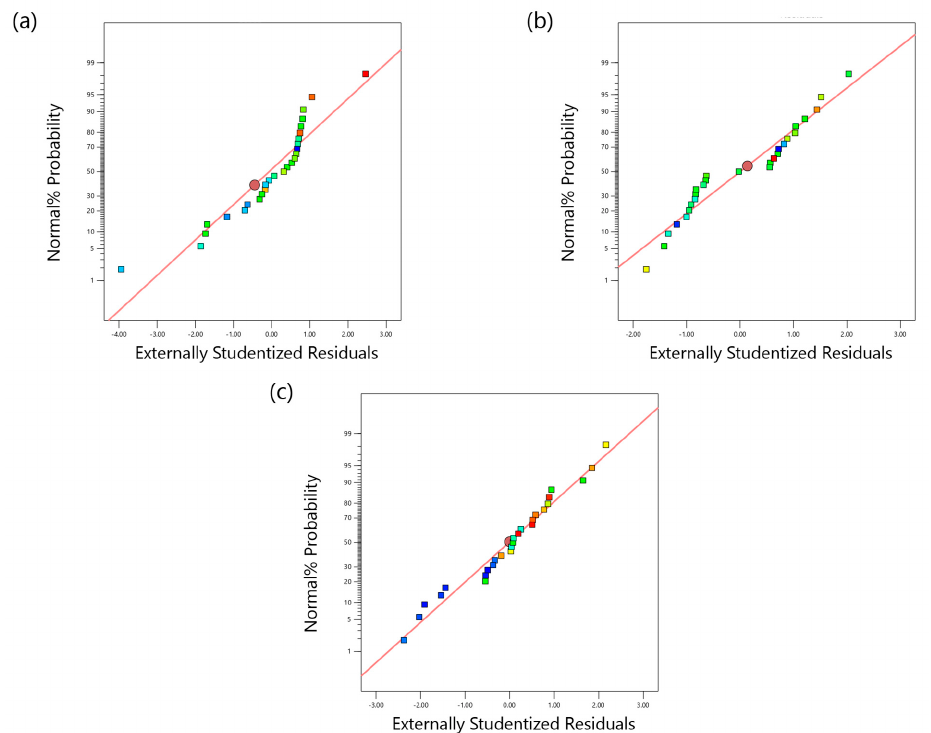
Figure 1. Normal probability vs. internally studentized residuals values for ( a ) TC removal, ( b ) TOC removal, and ( c ) TN removal.